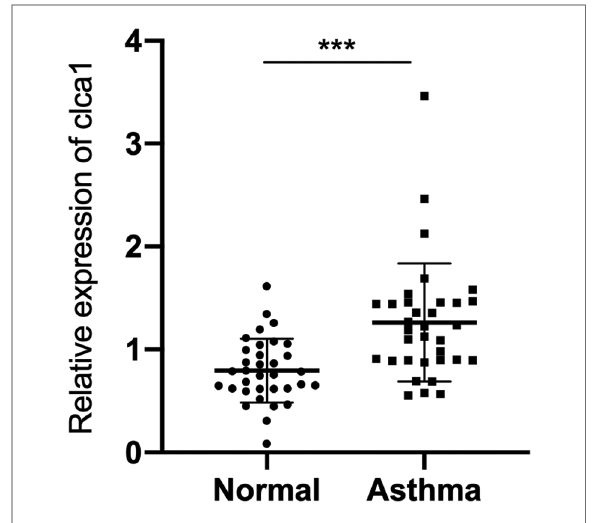
FIGURE 2 CLCA1 is highly expressed in the serum of children with asthma. RT-